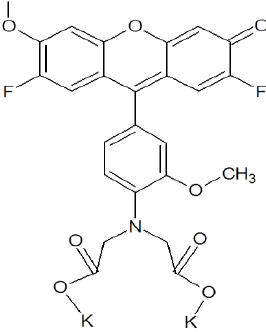
Figure 2. The chemical structure of